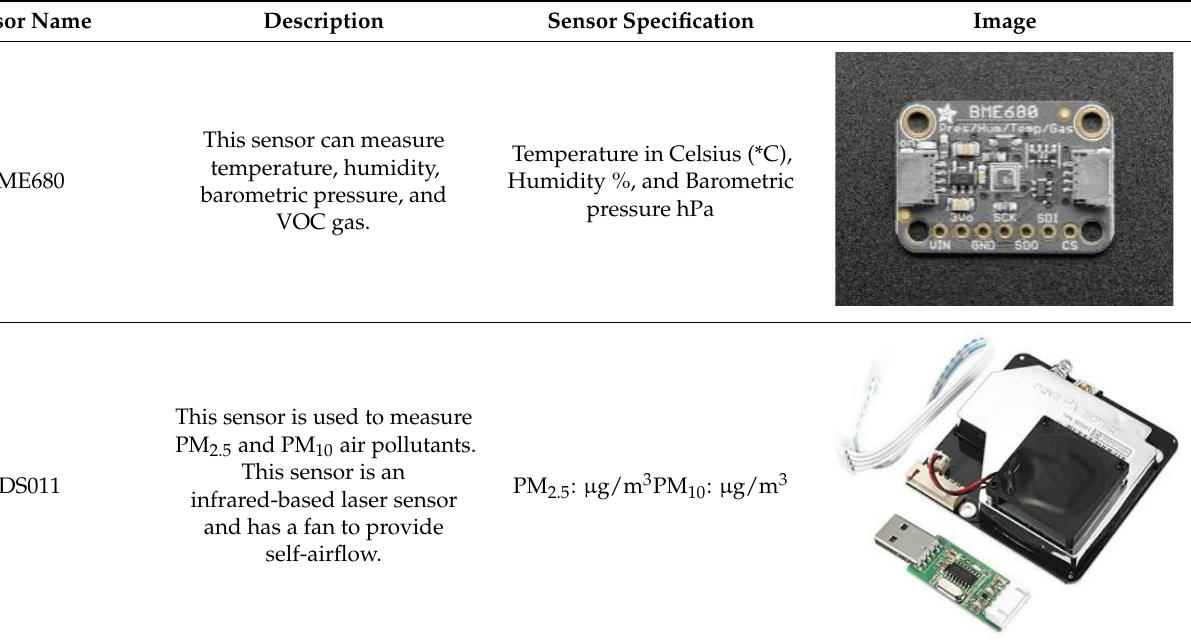
Table 1. List of low-cost sensors and their details used to conduct these studies.